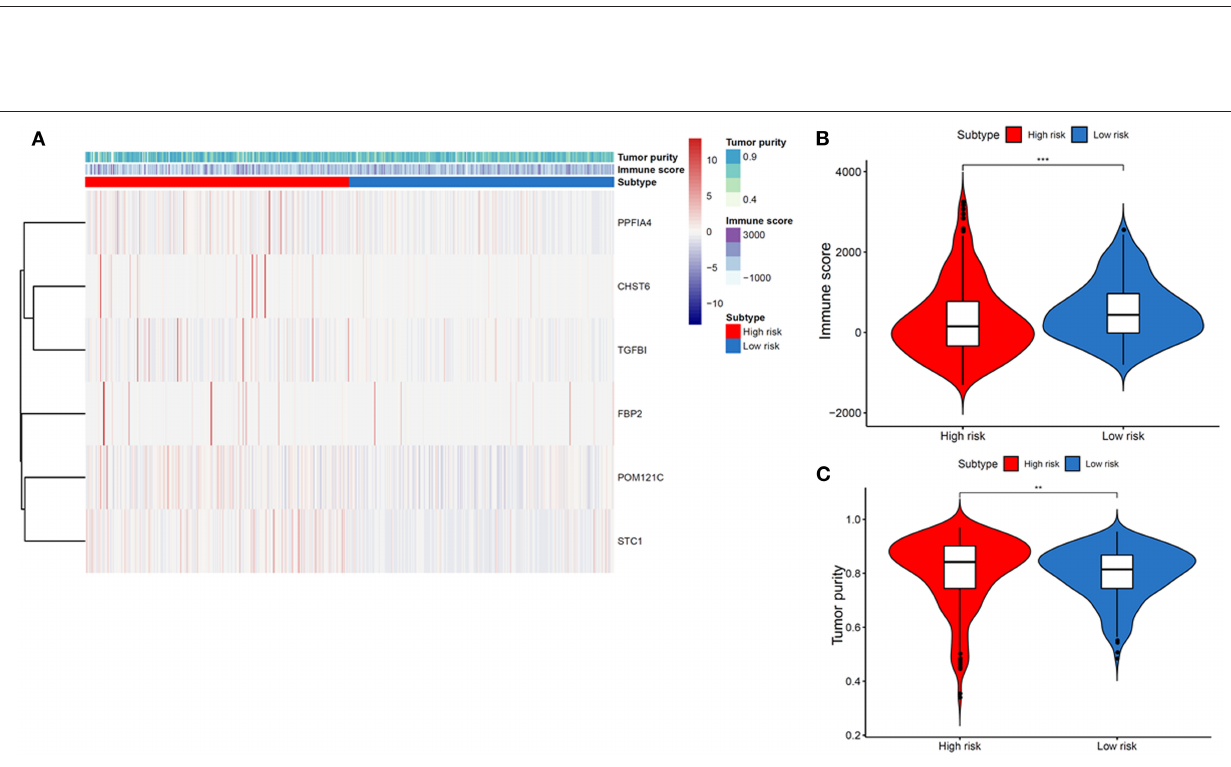
Frontiers in Oncology |